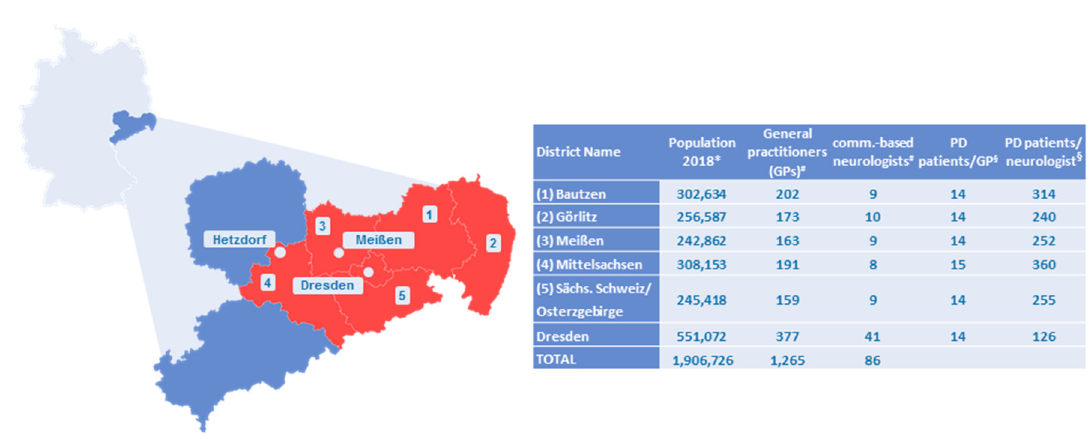
Figure 1. Characteristics of the intervention region Eastern Saxony. Germany is shown in light blue, the state Saxony in dark blue, and the intervention region Eastern Saxony in red. Within the intervention region, the three specialized hospital-affiliated outpatient centers are shown that will serve as the structural backbone of Parkinson Network Eastern Saxony (PANOS). The table on the right side gives population characteristics of the six districts within the intervention region. Eastern Saxony has a population of 1.9 million people, of which approximately 15,000 have Parkinson’s disease (PD). * General population numbers were taken from public statistical resources (https://www.statistik.sachsen.de/html/bevoelkerungsstand-einwohner.html). PD cases were calculated based on secondary health data from the biggest local statutory health insurer (AOKPLUS). Criteria were: International Classification of Diseases 10 th revision (ICD10) G20.x and prescription of dopaminergic medication as a validation criterion. The resulting prevalence of 786.69/100,000 matches the one of another recent German-wide epidemiologic study based on secondary health data [12,13] and was the basis for the § calculation of the number of patients per general practitioner (GP)/community-based neurologist. # Number of general practitioners (GPs) and number of neurologists was provided by the Association of SHI Physicians. Row “Total” gives the summed numbers for all six districts in the intervention region. Whereas the average number of PD patients per GP varies little between urban and rural districts (14 patients/GP), there was a huge variation in the average number of PD patients per neurologist between rural areas (up to 360 patients/neurologist in Mittelsachsen) and the city of Dresden (126 patients/neurologist).